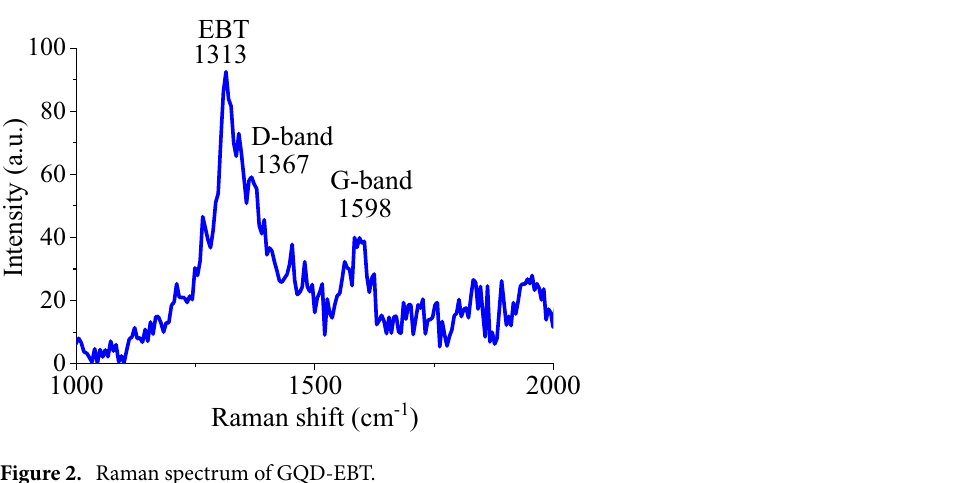
Figure 1. FT-IR spectra of GQD (red) and GQD-EBT (blue).